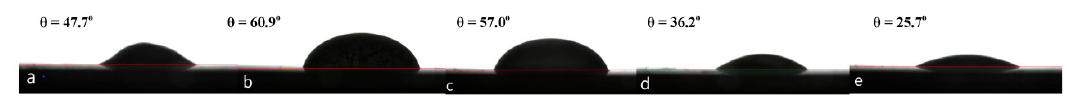
Figure 4. Contact angle of the film solutions of SPI and fractioned products: ( a ) SPI, ( b ) upper protein, ( c ) lower protein, ( d ) 11S globulin, and ( e ) 7S globulin.